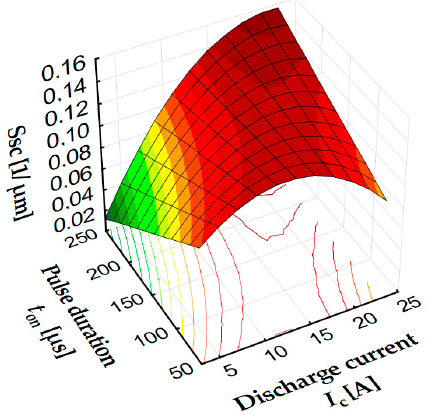
Figure 8. Estimated response surface for arithmetic mean curvature to the top Ssc.